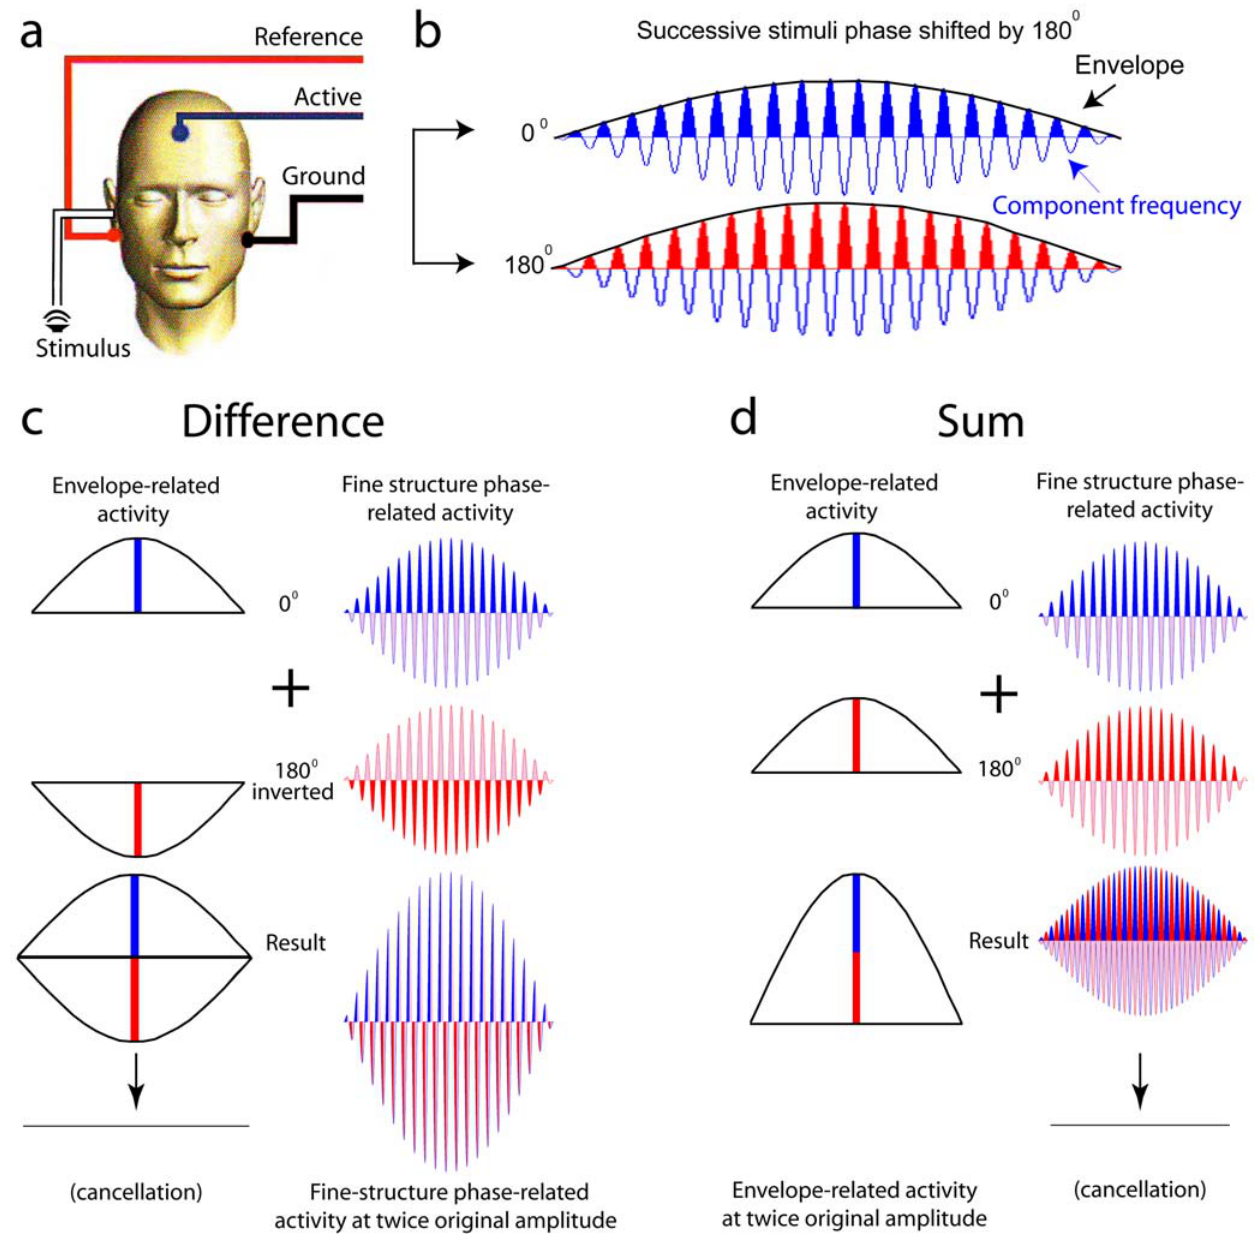
Figure 1. Experimental design. (a) Schematic location of stimulus presentation and recording sites on the scalp. (b) Successive stimuli were phase shifted by 180 u . This moves the locations of maxima and minima by K cycle relative to their unshifted values, leaving the envelope (black) unchanged but changing the relative location of maxima and minima in the component frequencies (the fine-structure, blue and red). (c) Difference waveform generated by multiplying the 180 u response waveform by 2 1 and adding it to the 0 u response waveform. Since the envelope-related activity near the maxima of the 180 u waveform (red) now has the opposite sign from that of the 0 u waveform (blue), these two cancel out; fine- structure-related activity now has the same sign for the 180 u and 0 u waveforms, yielding double the original signal strength. (d) Sum waveform generated by adding the 0 u response waveform to the 180 u response waveform. Envelope-related activity near the maxima now have the same sign (blue and red), yielding double the original signal strength; fine-structure-related activity now has opposite signs for the 0 u and 180 u response waveforms, canceling each other out.